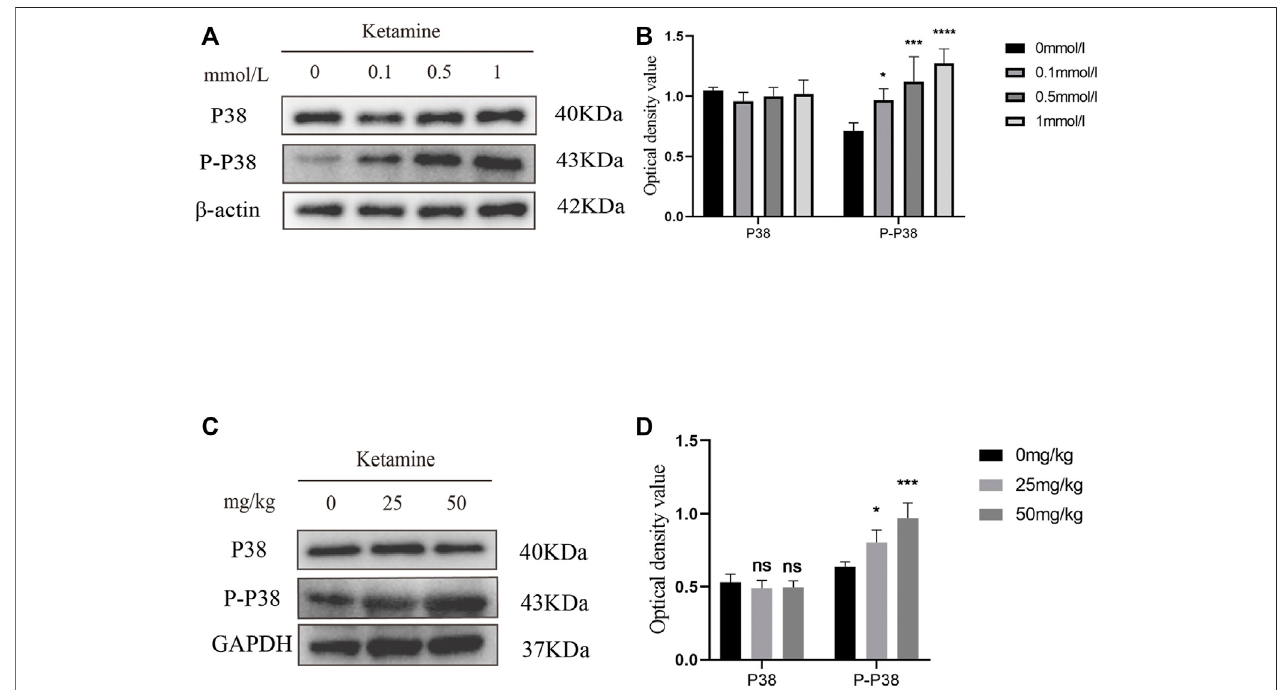
FIGURE 6 | The expression of P38 and P-P38 protein in SV-HUC-1 cells and rat bladder after treatment with different concentration of ketamine. (A) Representative bands from Western blot analyses ofthe levels ofthe P38and P-P38 protein in SV-HUC-1 cells after treatment with different concentrations ofketamine (treated for 48 h). (B) Relative levels of the P38 and P-P38 protein compared to β -actin in SV-HUC-1 cells. * p < 0.05 compared with 0 mmol/L group, *** p < 0.0001 comparedwith0 mmol/Lgroup, **** p < 0.0001compared with0 mmol/Lgroup. (C) RepresentativebandsfromWesternblotanalysesofthelevelsoftheP38and P-P38 protein in rat bladder after treatment with different concentration of ketamine (treated for 12 w). (D) Relative levels of the P38 and P-P38 protein compared to β - actin in rat bladder. * p < 0.05 compared with 0 mg/kg group, *** p < 0.0001 compared with 0 mg/kg group. N (cid:1)